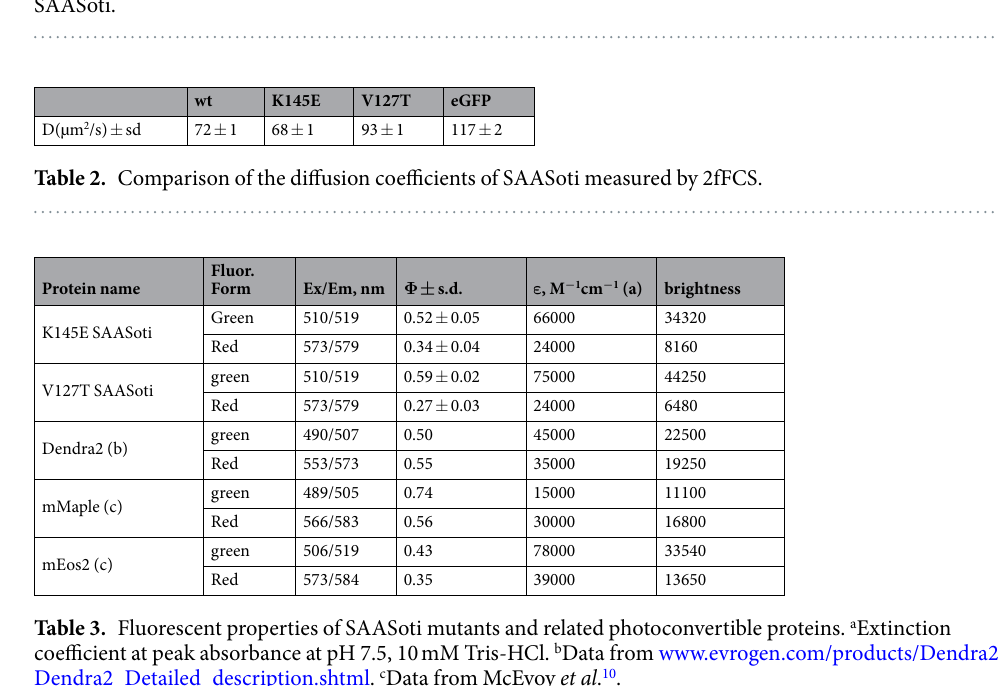
Table 3. Fluorescent properties of SAASoti mutants and related photoconvertible proteins. a Extinction coefficient at peak absorbance at pH 7.5, 10 mM Tris-HCl. b Data from www.evrogen.com/products/Dendra2/ Dendra2_Detailed_description.shtml. c Data from McEvoy et al . 10 .